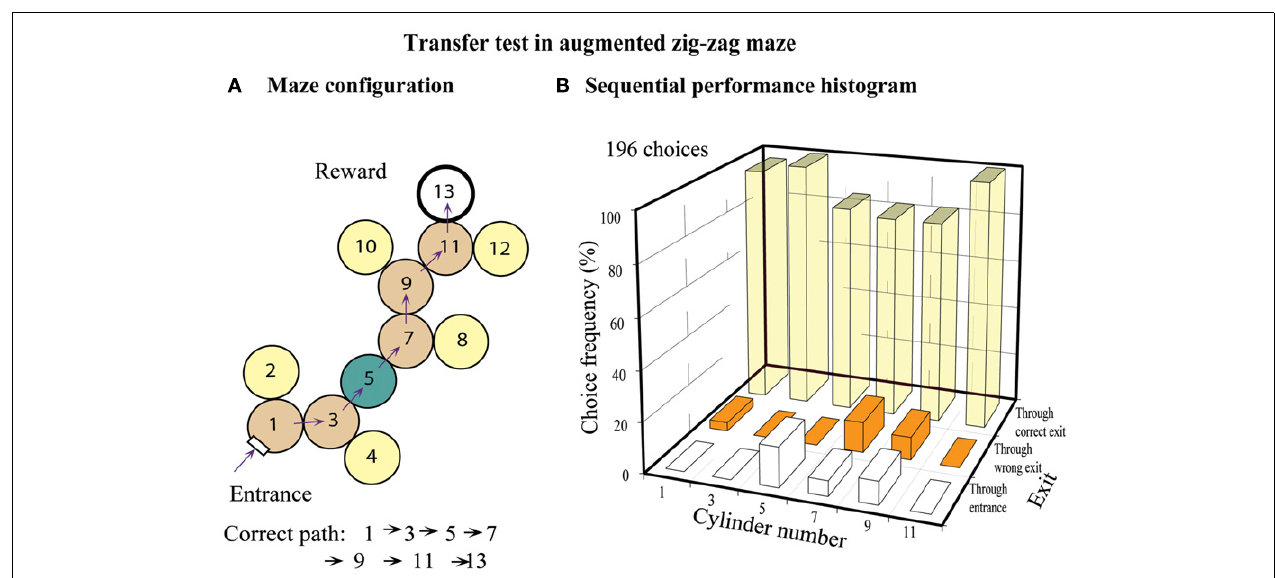
FIGURE 7 |Training in a zig-zag maze and transfer test in an augmented zig-zag maze. (A) Configuration of the augmented zig-zag maze, with an additional cylinder. (B) Histogram showing performance at each decision cylinder. Adapted from Zhang et al. (2000). Details in text.